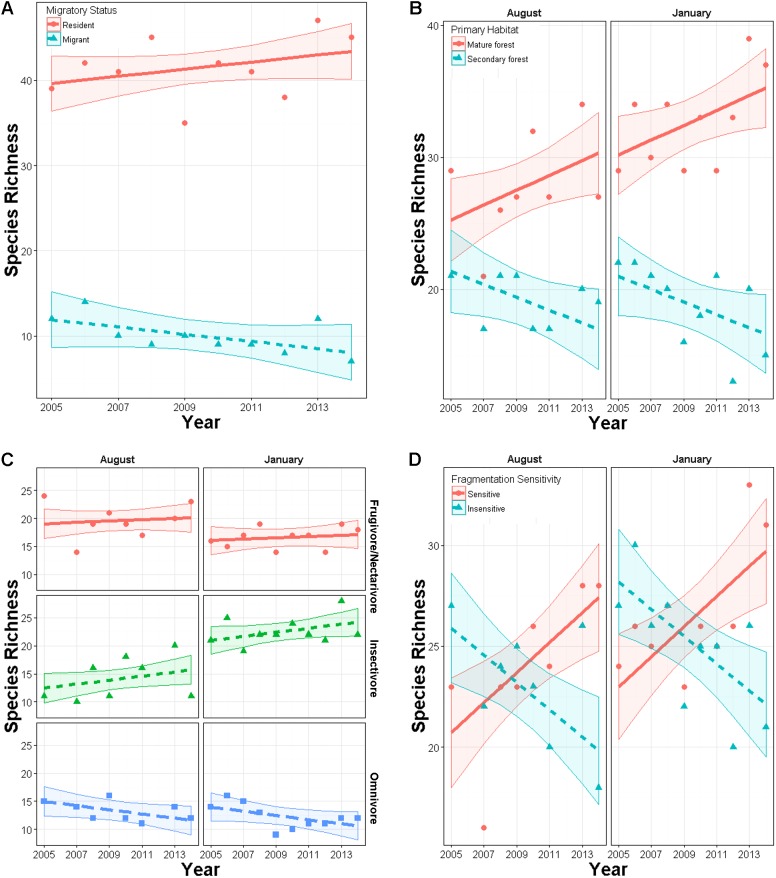
Changes in richness over a 10 year period in secondary forest plots in Costa Rica of: (A) species of permanent residents and Neotropical migratory birds; (B) species which prefer primary forest and those which prefer secondary forest, scrub or edge habitat; (C) species with different diet preferences (frugivores–nectarivores combined with seedeaters, insectivores, and omnivores); (D) species with different sensitivities to habitat degradation.Error bands represent approximately 95% CI.